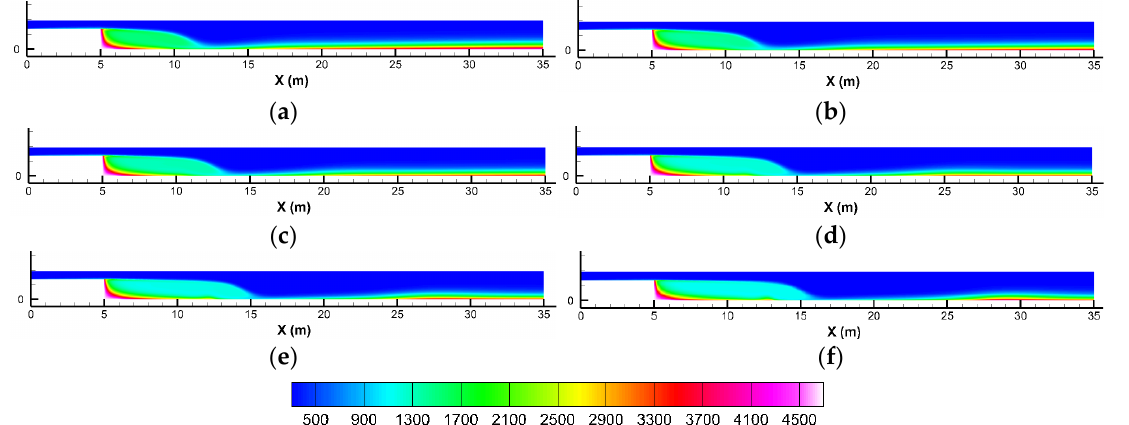
Figure 6. Temperature contours at various Reynolds numbers; ( a ) 200, ( b ) 250, ( c ) 300, ( d ) 400, ( e ) 450, and ( f ) 500.